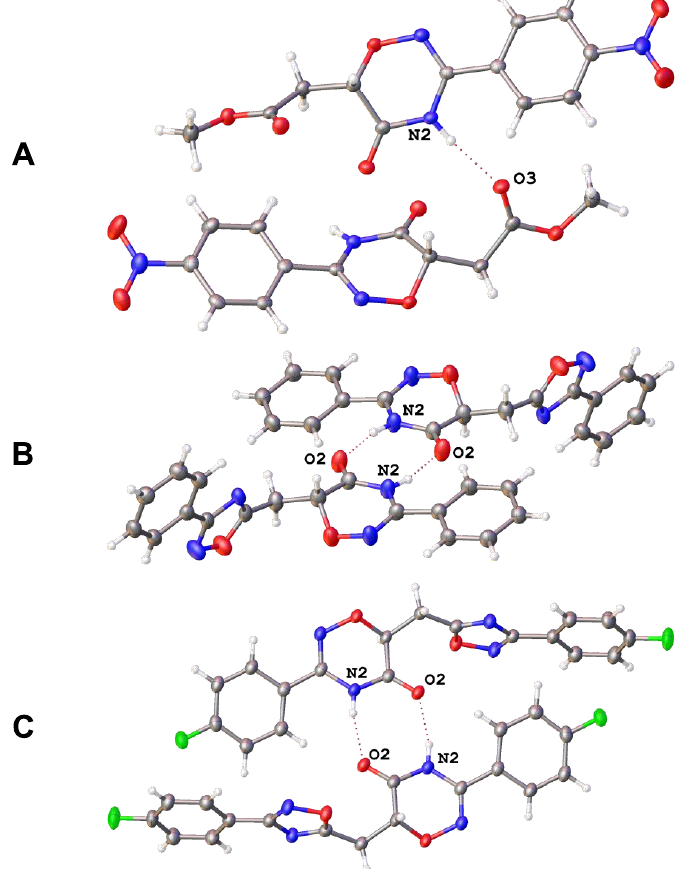
Figure 1. Hydrogen-bonded dimers in crystals of 4d ( A ), 5b ( B ), and 5f ( C